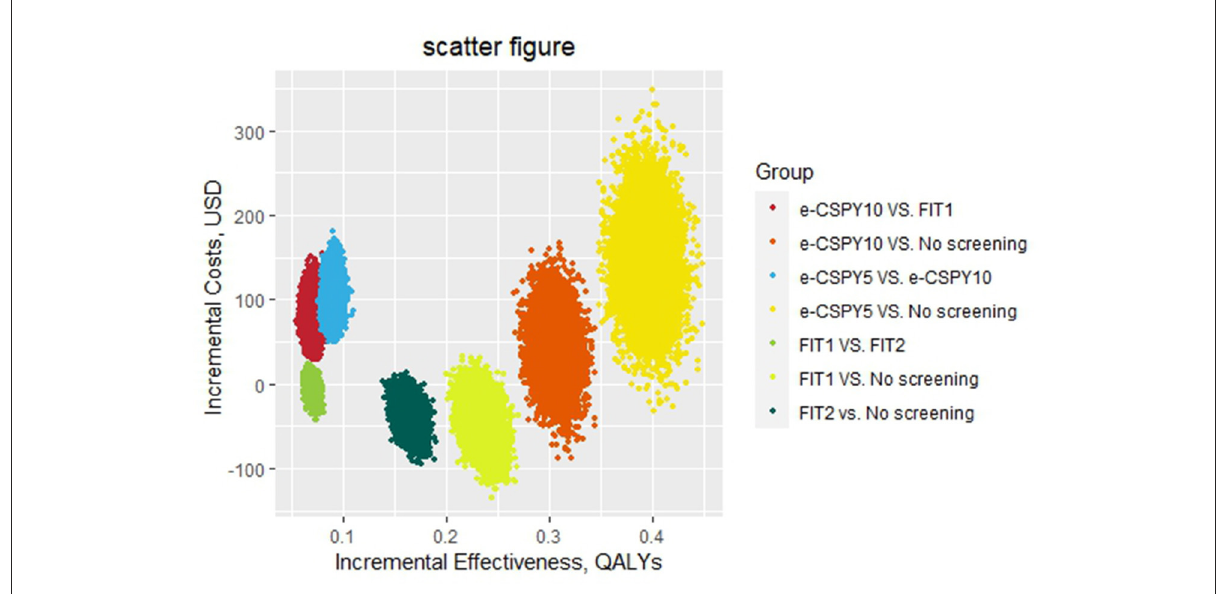
FIGURE4 The scatter figure of the probabilistic sensitivity analysis. E-CSPY10/5, electronic colonoscopy every 10/5 years; FIT1/2, annual/ biennial FIT.